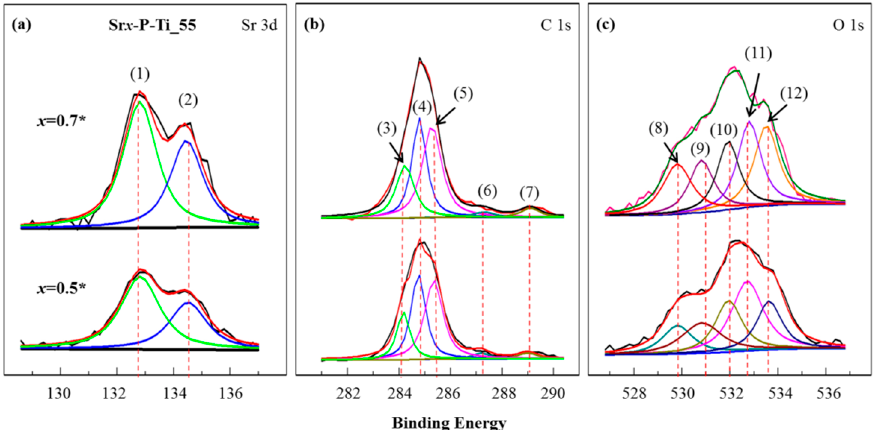
Figure 5. Curve-fitting data for XPS spectra of ( a ) Sr 3d, ( b ) C 1s, and ( c ) O 1s on x = 0.5* and x = 0.7*, respectively. The curve-fitted peaks are respectively assigned: (1) 132.9 eV, Sr 3d 5/2 , (2) 134.6 eV, Sr 3d 3/2 , (3) 284.2 eV, C=O, (4) 284.8 eV, C–C, (5) 285.5 eV, C–H, (6) 287.1 eV, C–O, (7) 289.2 eV, COO, (8) 529.8 eV, O-containing ions in SrO, (9) 531 eV, C-O, (10) 532 eV, loosely bound hydroxide groups, M–